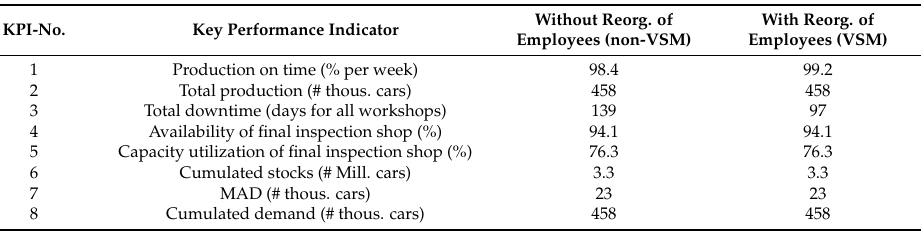
Table 4. Case study